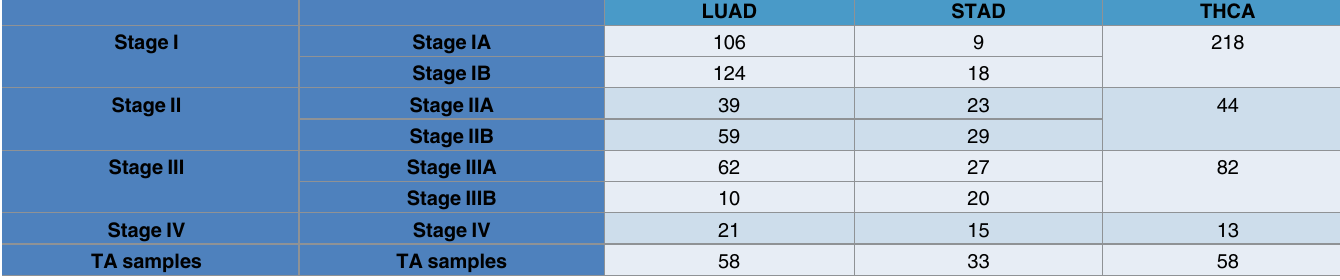
Table 1. The number of tumor samples within each stage in the cancer dataset from TCGA.